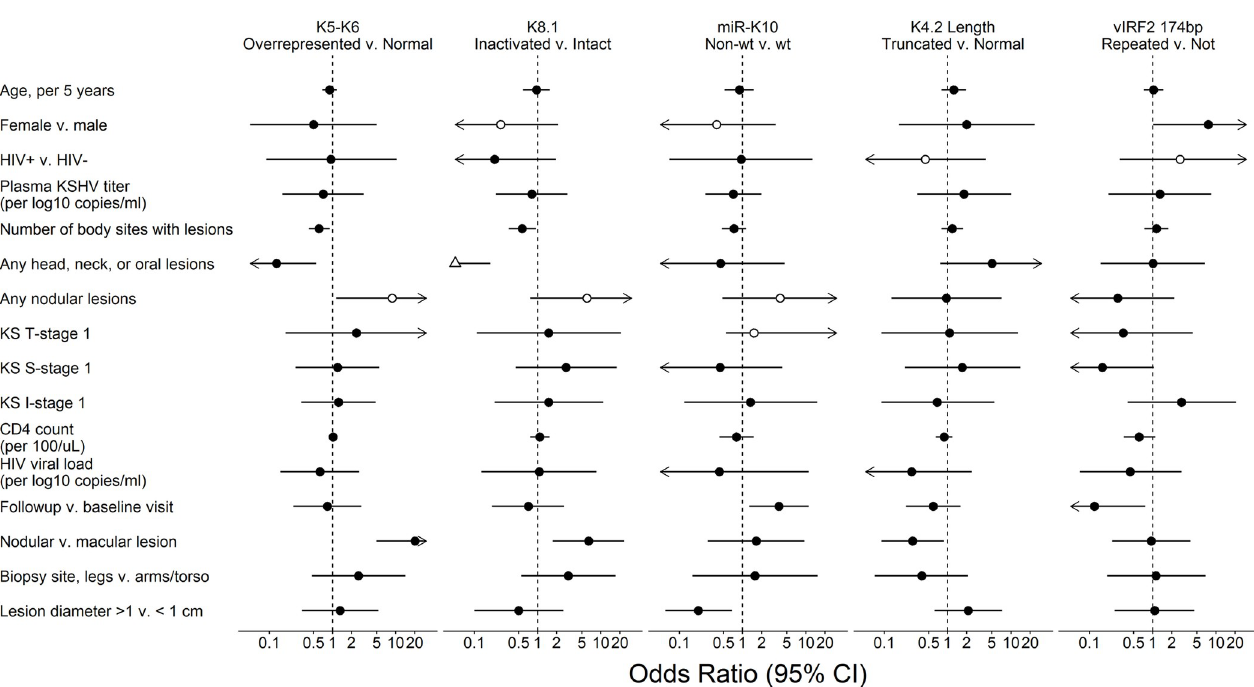
Fig 8. Associations between observed KSHV mutations and clinical traits. Forest Plot of the odds ratio (OR) of participant and tumor characteristics with KSHV mutations from regression analysis of KS tumors from 29 participants, univariable analysis. Filled symbols were estimated with logistic regression and hollow symbols with exact logistic regression. Triangle indicates the OR point estimate is outside of the plotted range. Arrows indicate that the plotted range extends beyond the scale bar below.